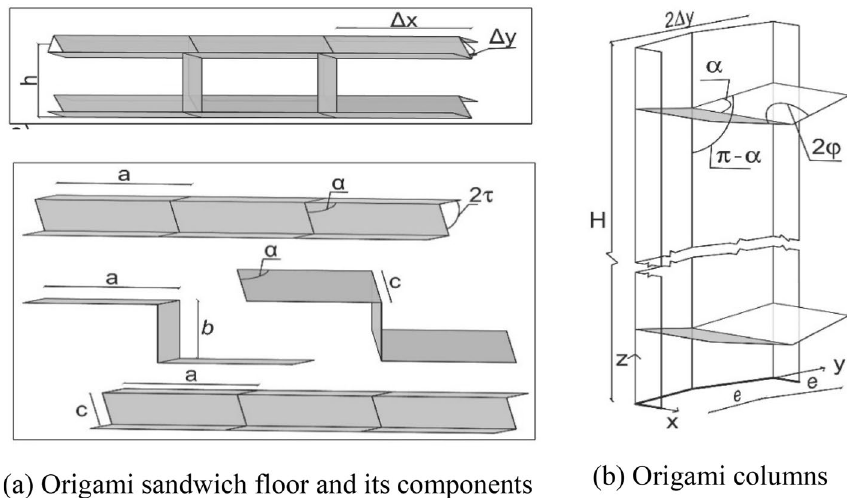
Figure 9. Proposed origami sandwich floor/roof and origami columns for the origami-like modular unit. ( a ) Origami sandwich floor and its components. ( b ) Origami columns.